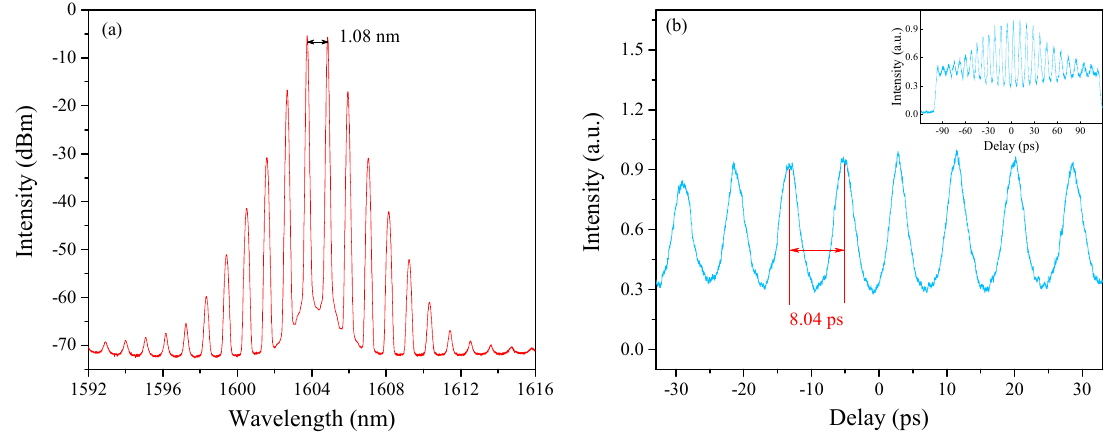
Sensors 2021 , 21 , x FOR PEER REVIEW